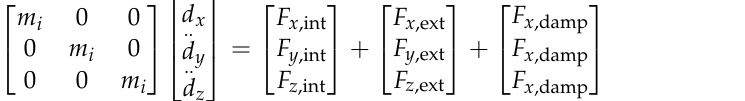
force in member elements, which can be obtained through the model of member elements;